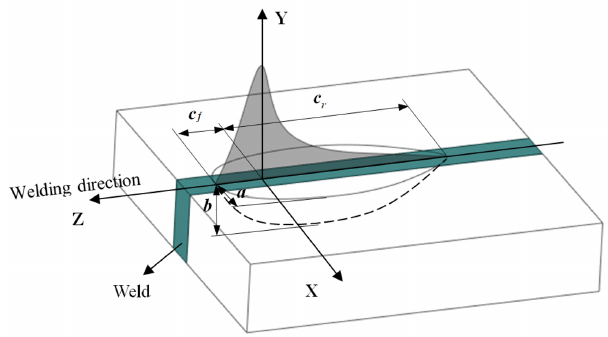
Figure 5. Double ellipsoidal heat source model. Table 2. Double ellipsoid heat source shape parameters of Model I.